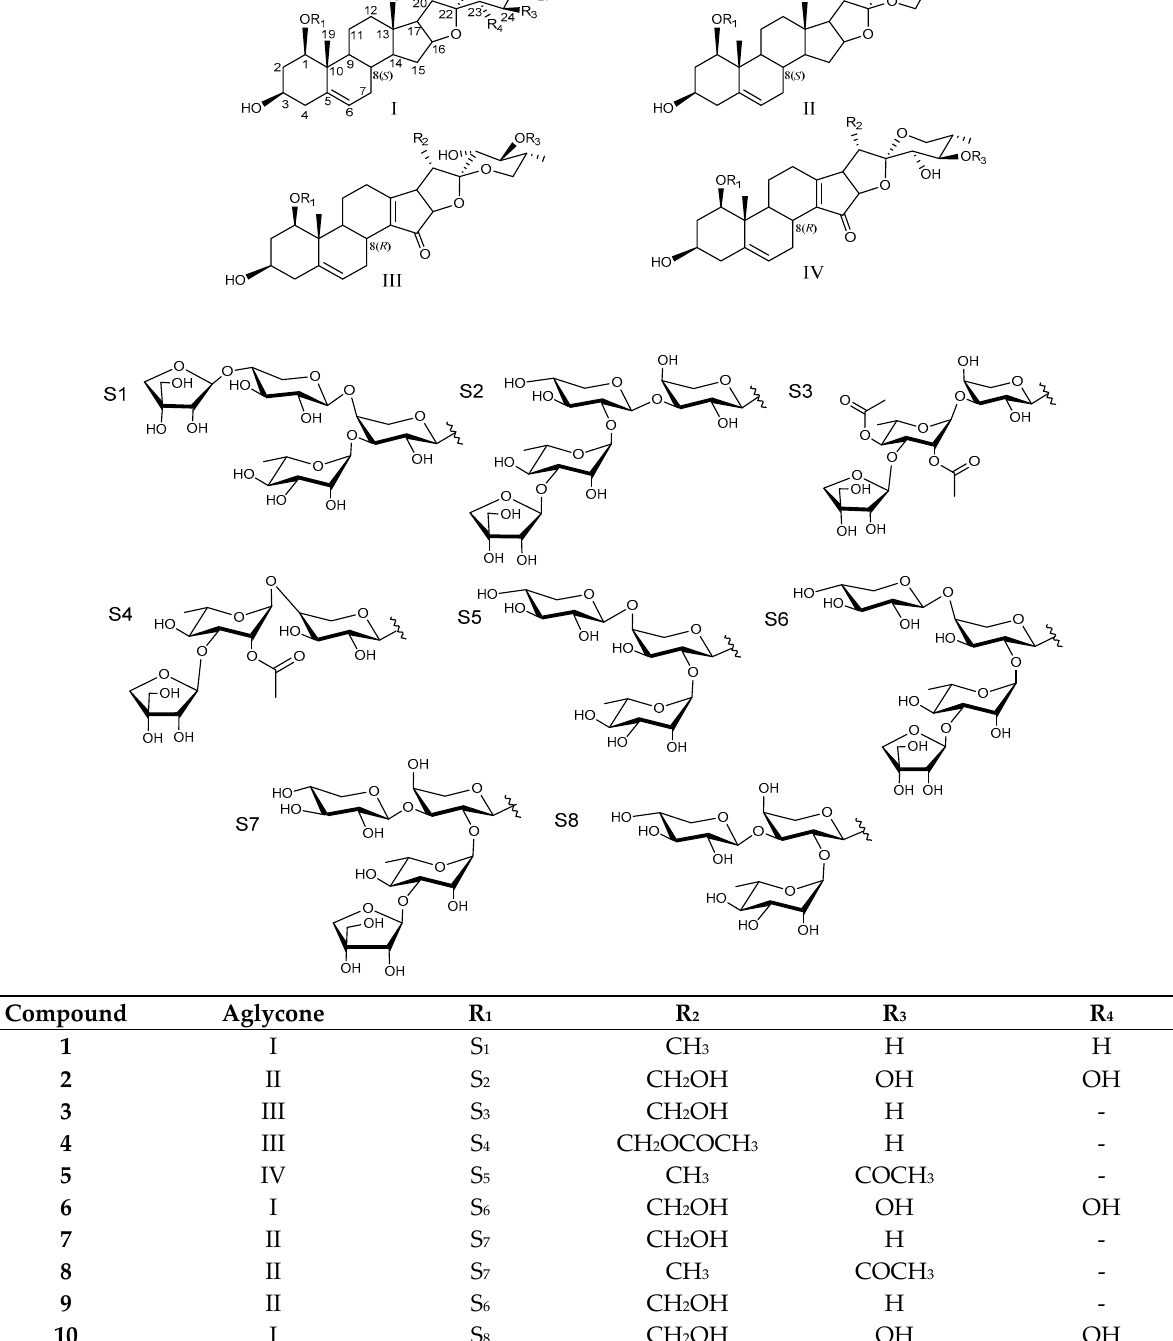
Figure 1. Structures of compounds 1 – 10 .